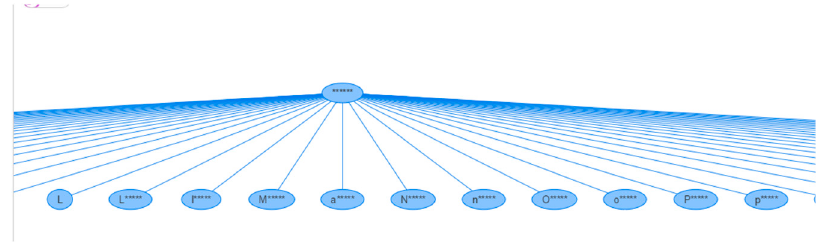
Figure 14. Hierarchy userlocation.